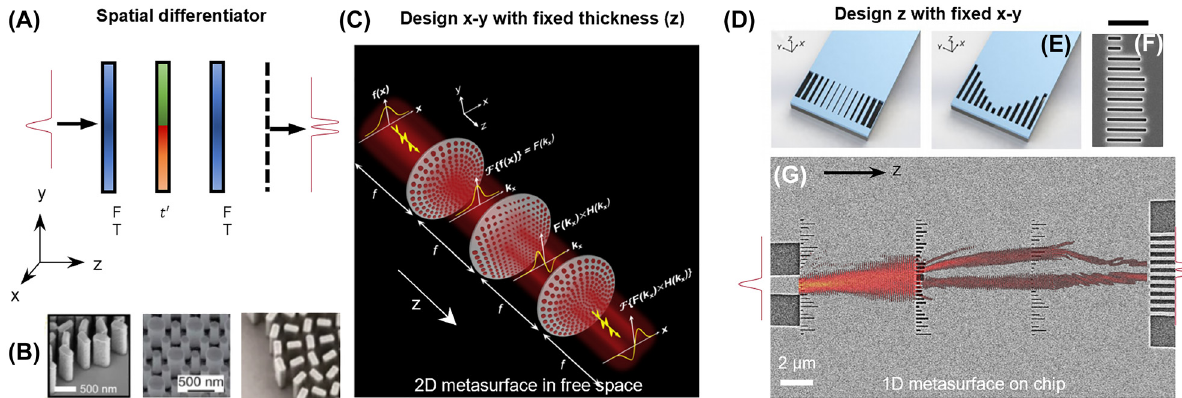
Figure 3: Fourier optic implementation of a spatial differentiator. (A) Schematics of a three-layer spatial differentiation system for diffraction. (B) Scanning microscope images (SEMs) of dielectric [f1] and metallic metasurface; the transmitted wavefront can be designed towards multi-layer metasurface systems. (C) Schematic illustration of a three-layer metasurface system, composed of two metalens for Fourier transformation and middle layer of designed mask [49]. (D) Design of integrated metalens by varying lattice constant and (E) trench length [50]. (F) SEM image of the 1D metasurface defined on SOI substrate. Scale bar: 1 μ m. (G) SEM image of a spatial differentiator based on integrated metasurfaces [6]. © 2020, The